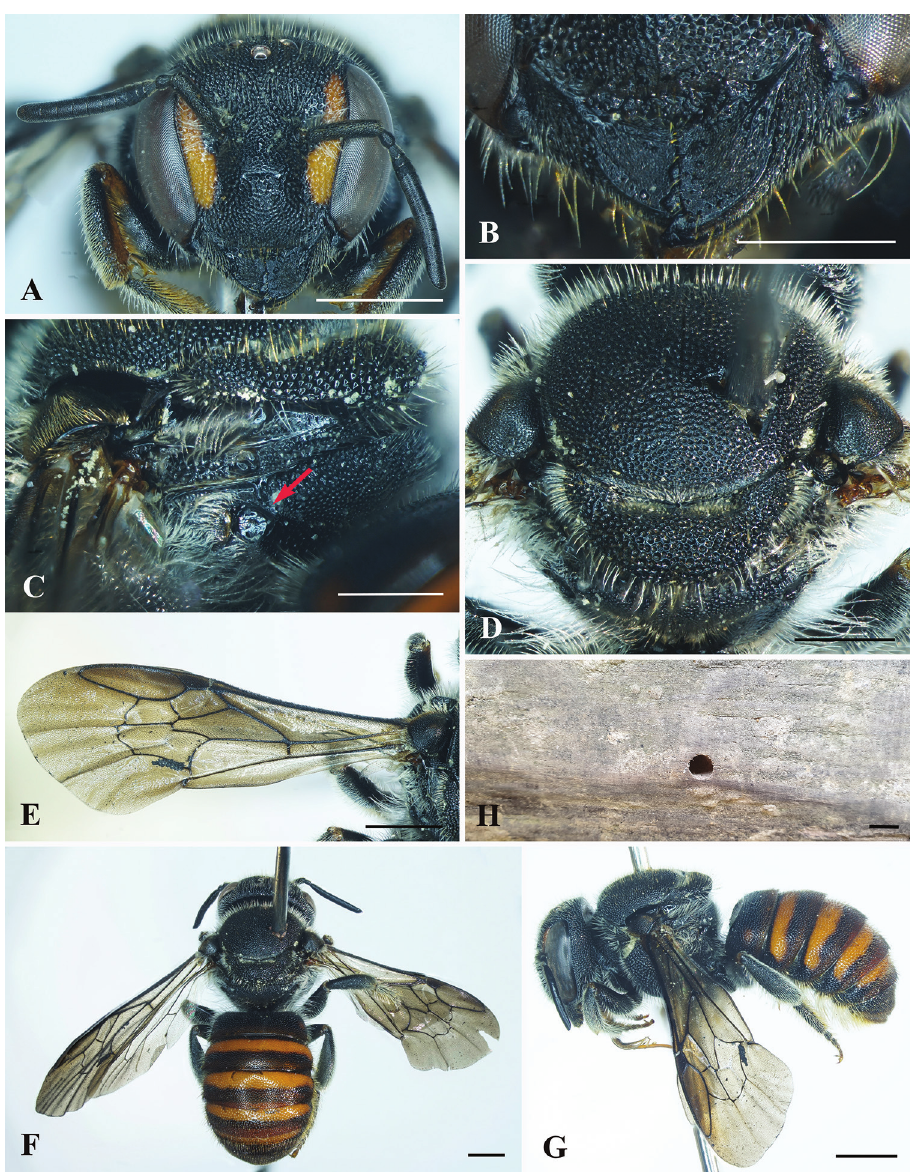
Figure 1. A–H Bathanthidium ( Bathanthidium s. str.) paco Tran & Nguyen, sp. nov., holotype, female A head in frontal view B mandible in frontal view C propodeum in lateral view, showing the fovea behind propodeal spiracle D mesoscutum and scutellum in dorsal view E fore wing in dorsal view F habitus in dorsal view G habitus in lateral view H nest entrance. Scale bars: 5 mm ( H ) ; 1 mm ( A, C, E, F, G ); 0.5 mm ( B, D